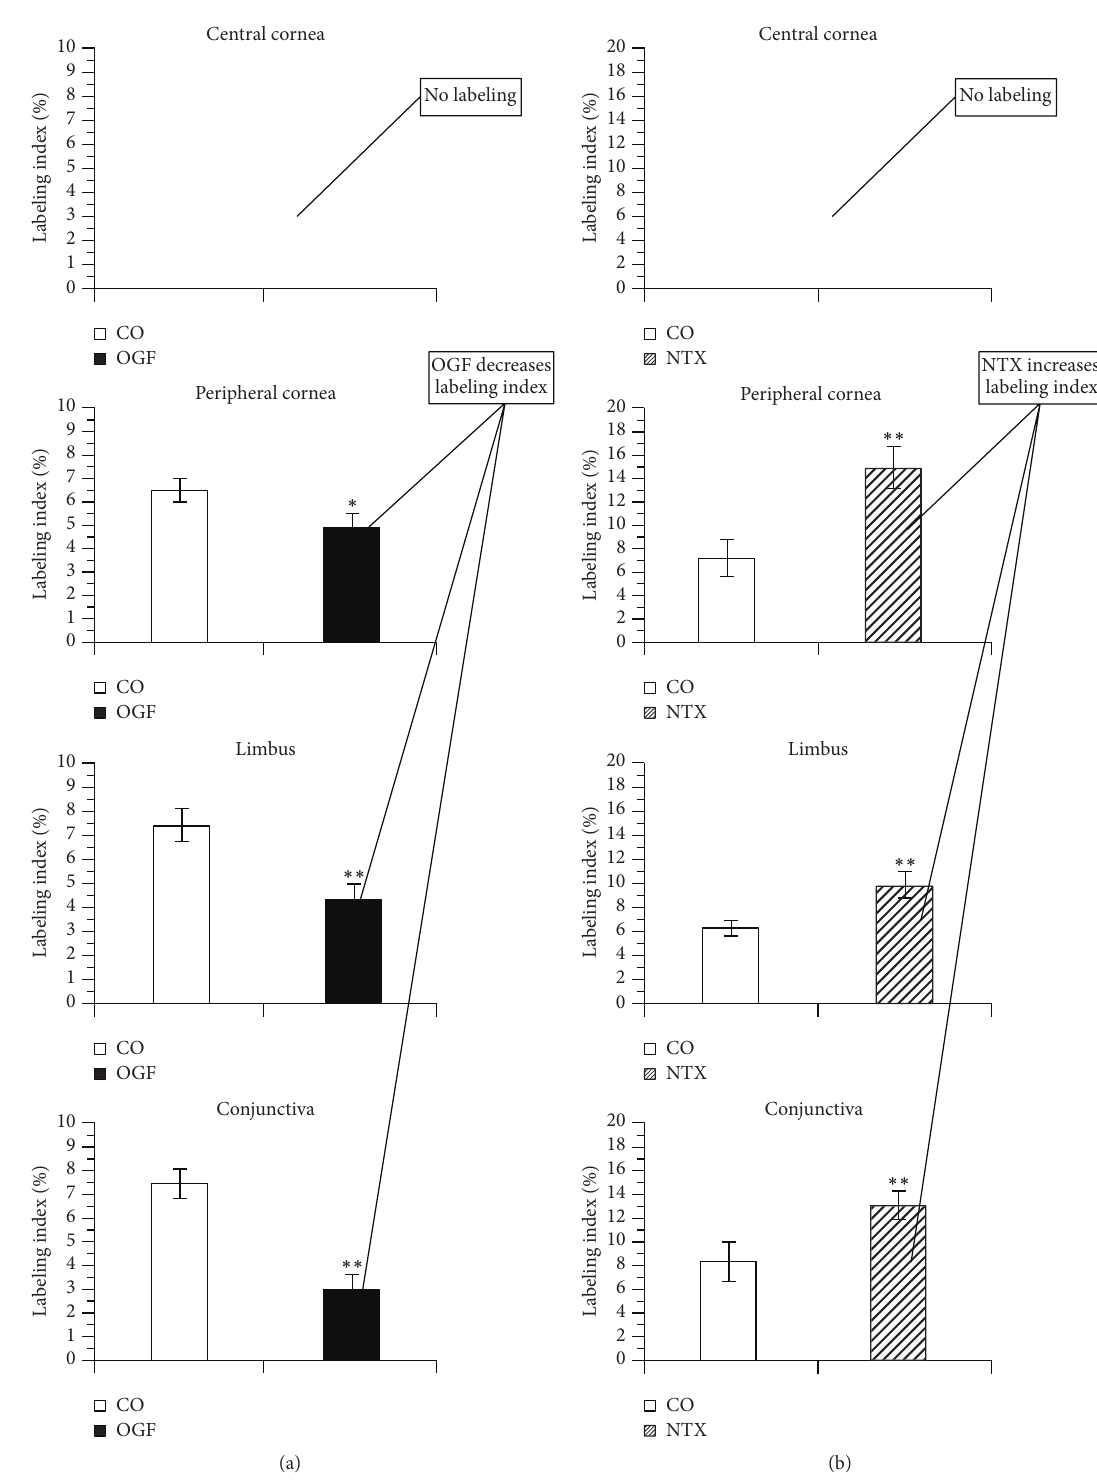
Figure 5: In vivo rat cornea: effects of OGF and NTX. Labeling index of basal corneal epithelium in the central cornea, peripheral cornea, limbus, and conjunctiva. Left series of histograms: OGF decreases labeling index of homeostatic rat corneal epithelium. Right series of histograms: NTX increases labeling index of homeostatic rat corneal epithelium. Note: neither OGF nor NTX has any effect on the central corneal epithelium (right and left, top graphs), which is postmitotic. ∗ 𝑃 < 0.05 or ∗∗ 𝑃 < 0.01 (derived from